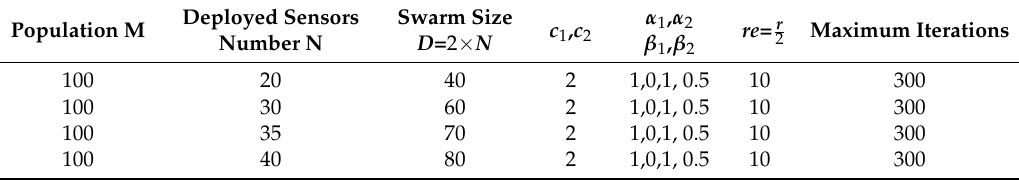
Table 1. The condition for simulation experiment.